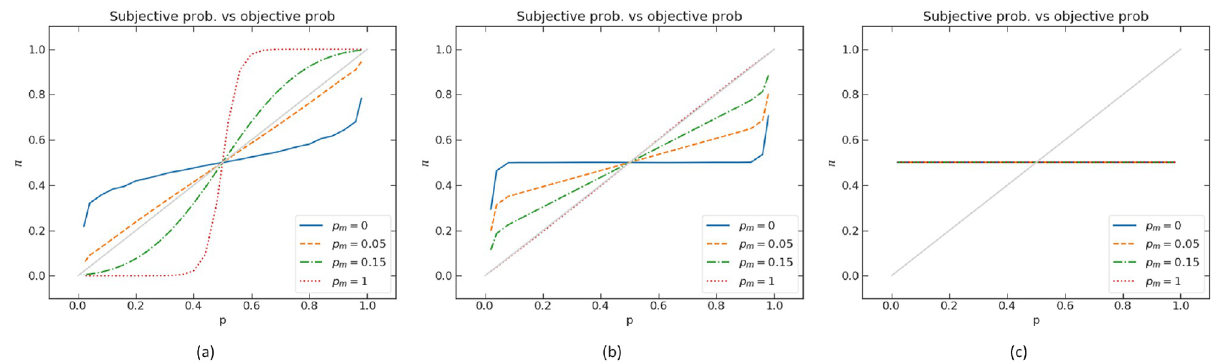
Fig 8. Subjective probability π vs objective probability p for different values of the probability p performed on the quantum walk. The objective probability p is encoded in the relative lengths of branches explored by the quantum walk, as explained in the text. The parameter of the walks are (a) t = 75, ρ = 0.5. (b) t ! 1 , ρ = 0.5. (c) t = 75, ρ =